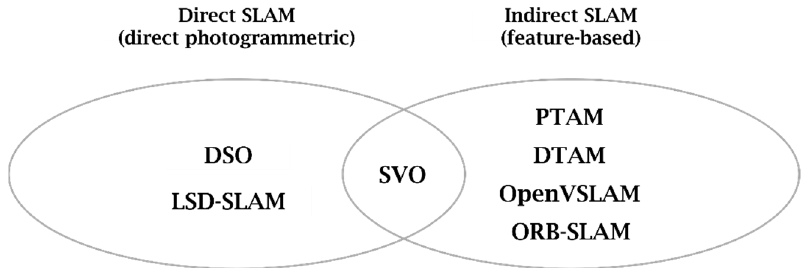
Figure 1. Direct SLAM and indirect (feature-based) SLAM.